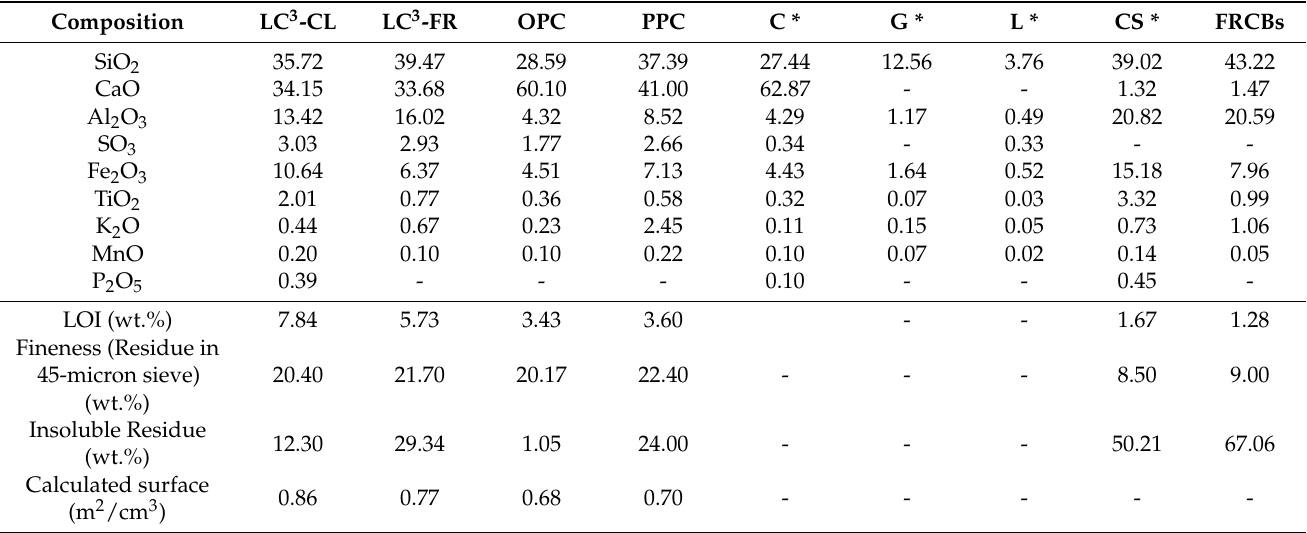
Table 1. Chemical composition (in wt.%) and selected physical properties of raw